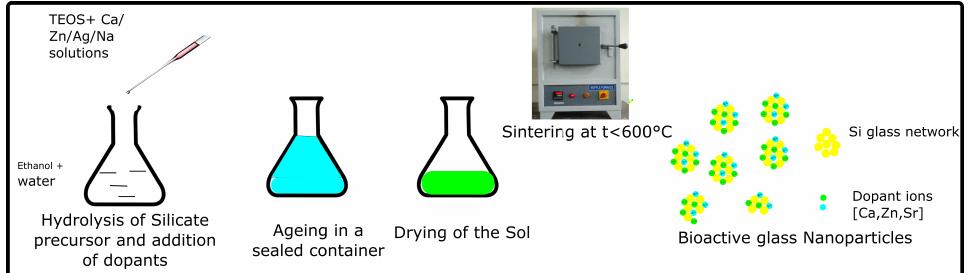
Figure 2. Schematic of the sol–gel synthesis of bioactive glass nanoparticles (image adapted from CC BY-SA 3.0